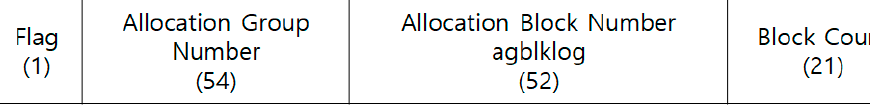
Figure 9. Structure of data extents of XFS file system.